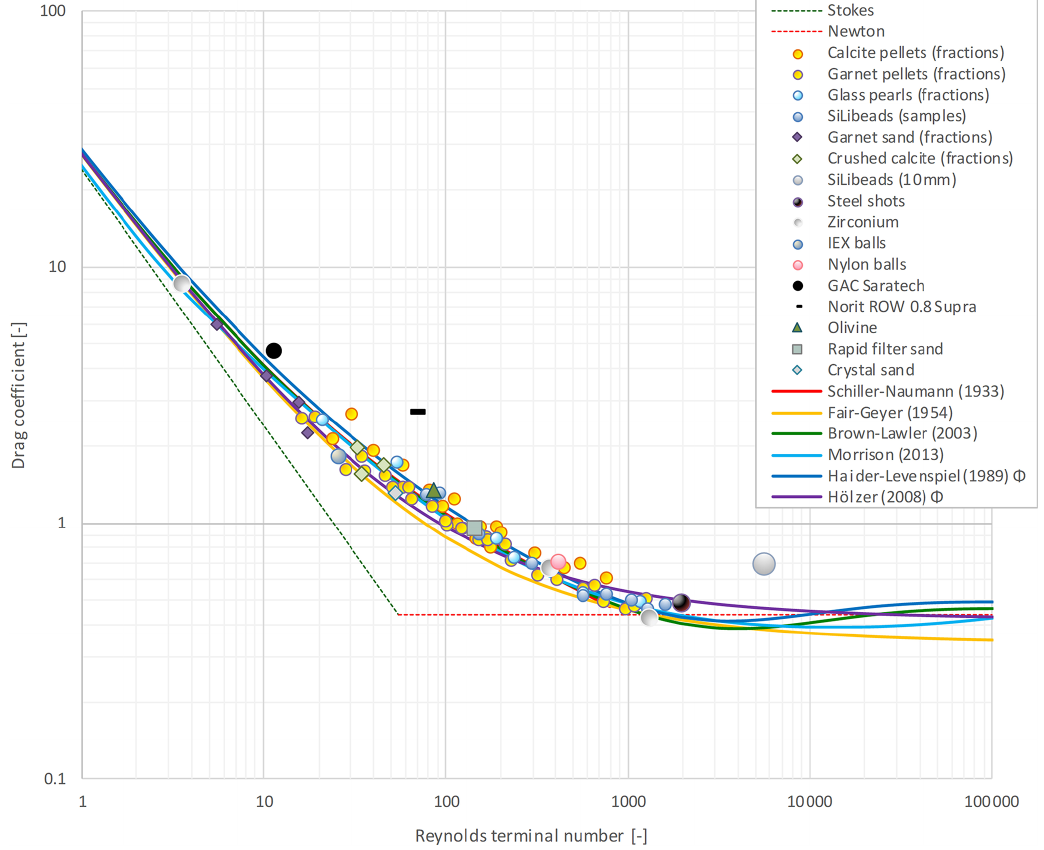
Figure 3. Standard drag curve (SDC) for 3629 grains, using averaged values over multiple experiments, for 16 types of materials compared with popular prediction models for spherical and non-spherical particles. The symbol (cid:56) indicates that the measured sphericity is included in the model. Extended SDC, with all examined models, is given in the Supplement (Sects. S5 and